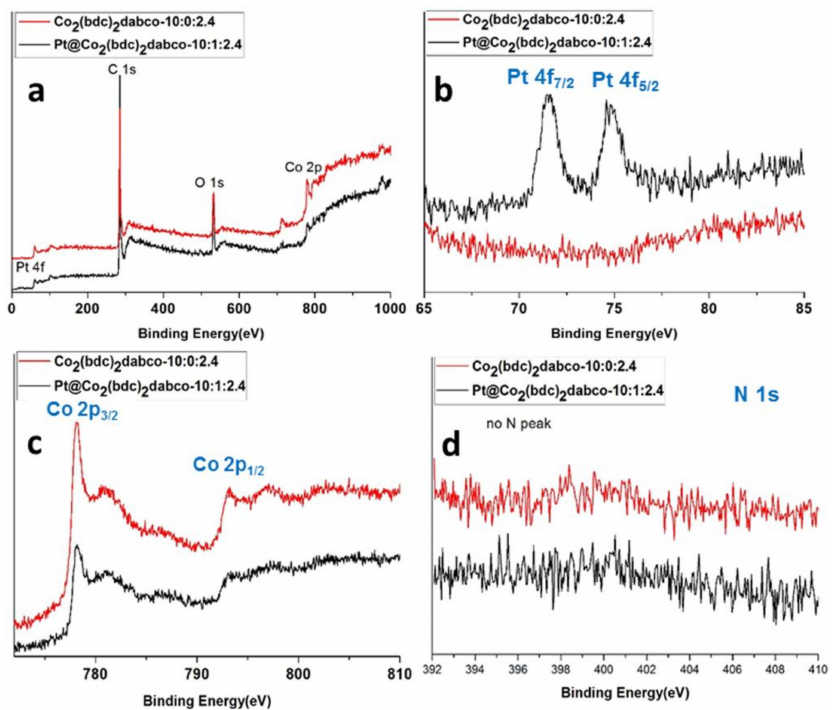
Figure 4. XPS analysis of Co/C and Pt@Co/C (10:1:2.4) ( a ) XPS total survey scan, ( b ) XPS deconvolution of Pt 4f, ( c ) XPS deconvolution of Co 2p and ( d ) XPS deconvolution of N